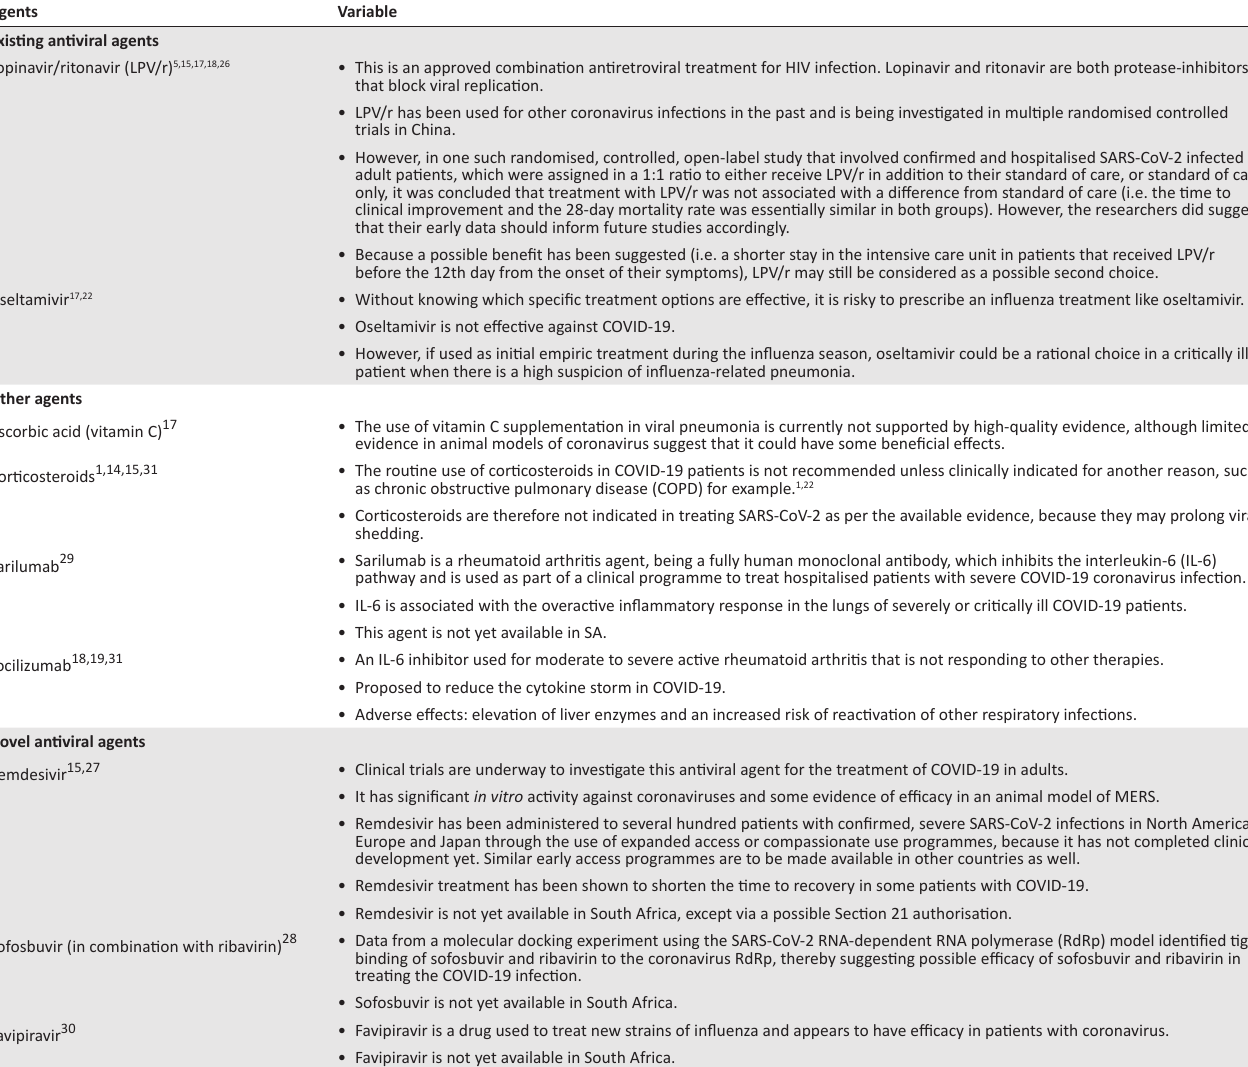
TABLE 4: Treatment options under investigation for use in patients with COVID-19. 1,5,14,15,17,18,19,22,26,17,18,19,30,31 Agents Variable